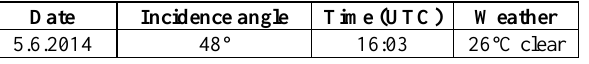
Table 2. TDX image pair used in the study. Image data were acquired from the ascending orbit.